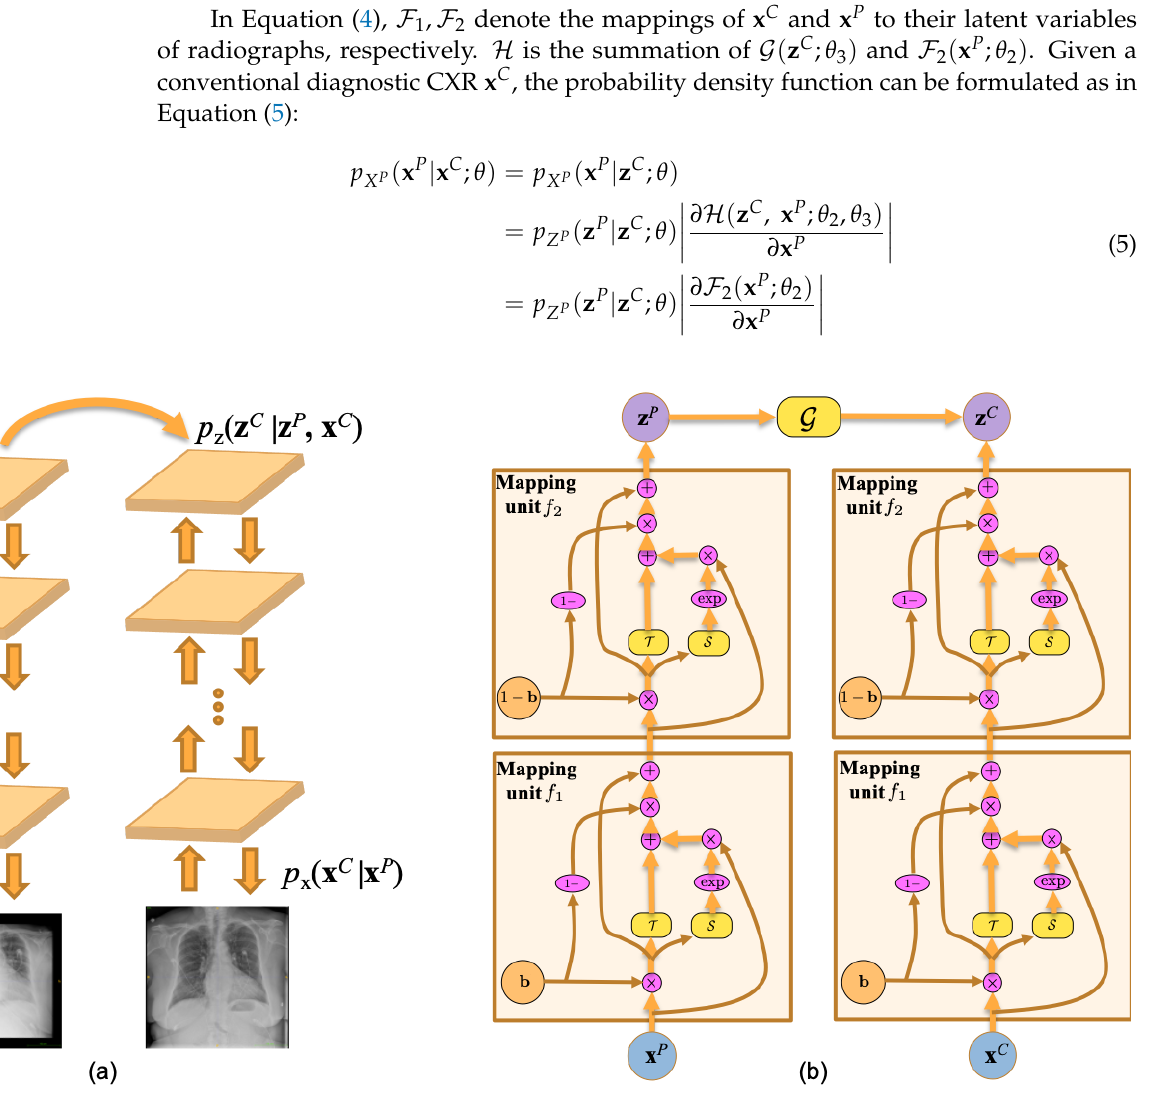
Figure 6. Our proposed PairFlow deep network for image enhancement between the source domain (P) and target domain (C): ( a ) invertible CNN-based PairFlow Network for portable radiograph enhancement; and ( b ) a mapping unit f whose transformations S and T are represented with a one-residual-block CNN